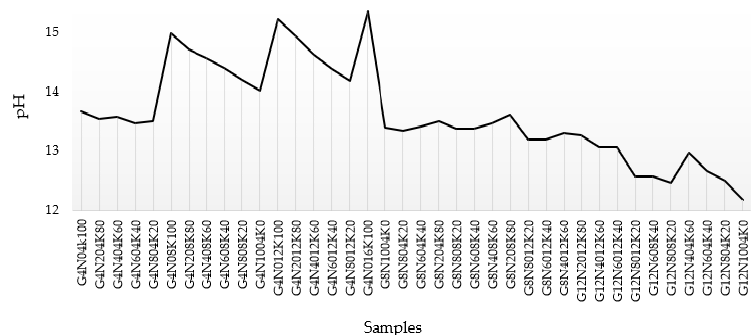
Figure 3. pH values of geopolymer samples.